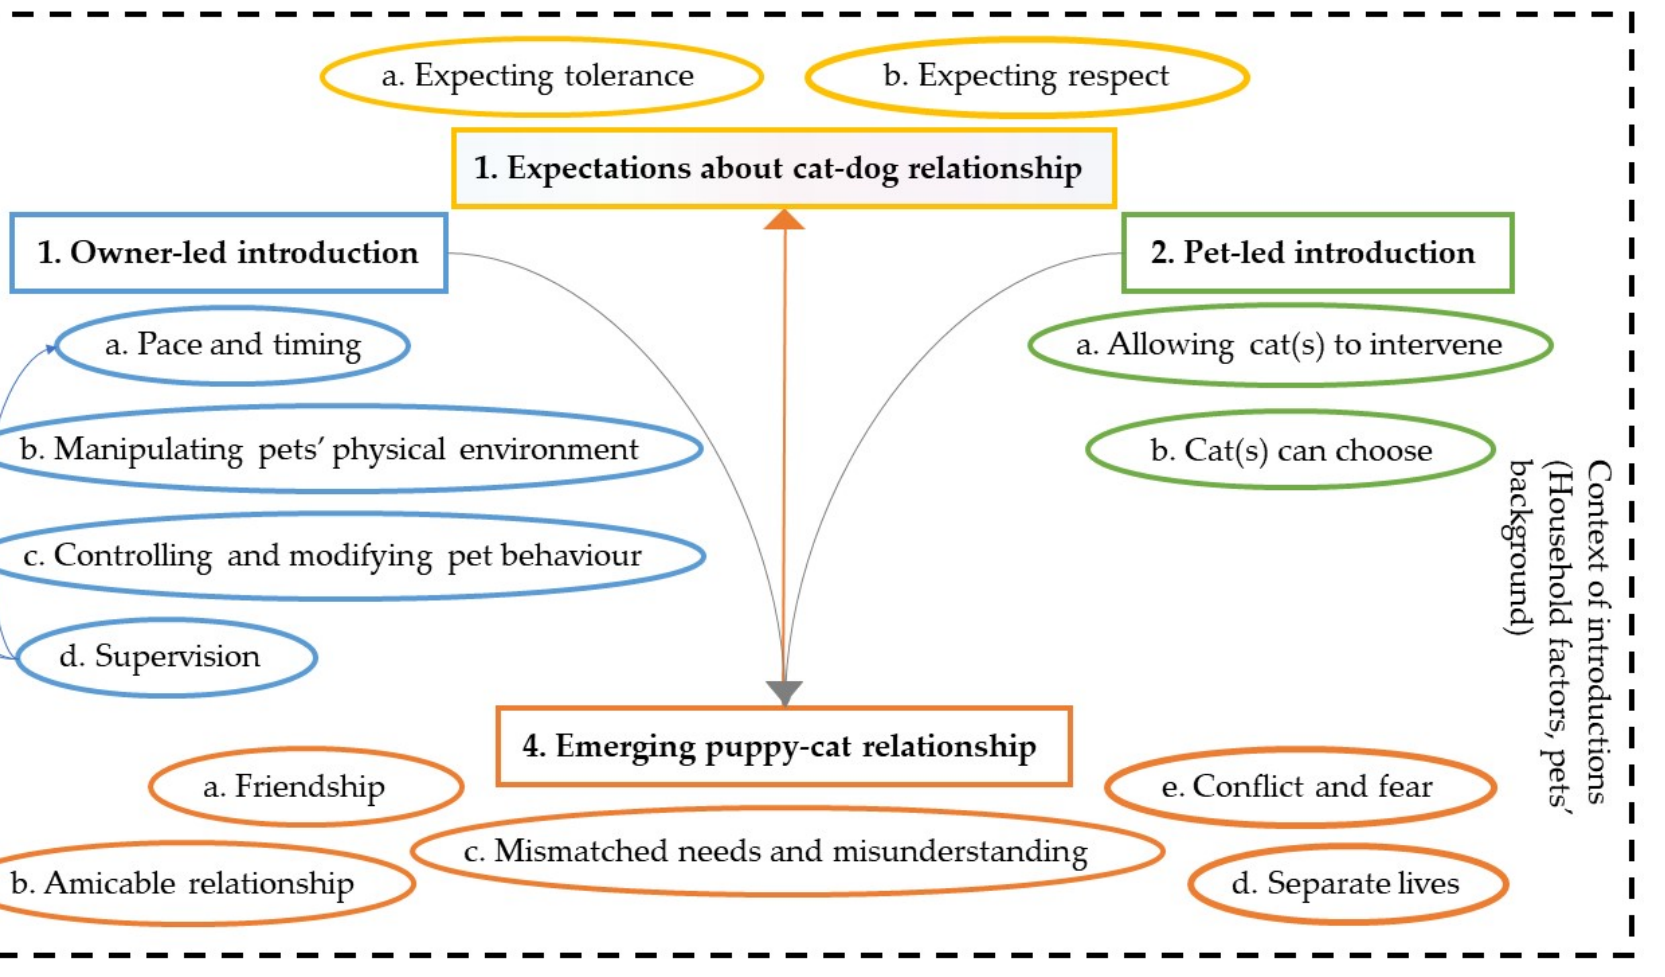
Figure 2. Schematic representation of themes and sub-themes that described puppy owners’ approaches to, perceptions and expectations of introducing a puppy to an existing household cat.